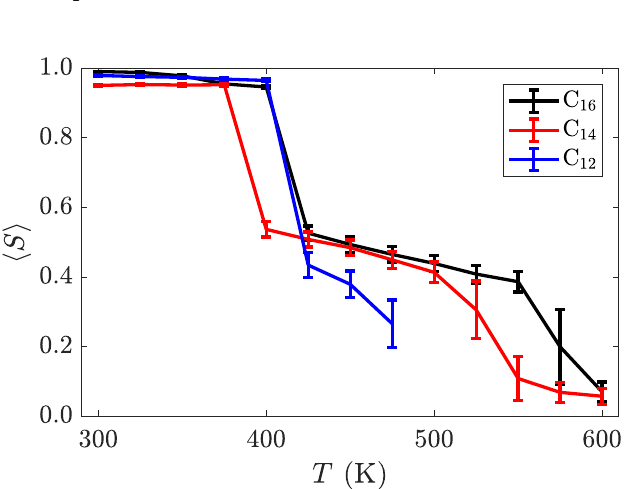
Figure 6. Nematic order parameter as a function of temperature for three different alkyl chain lengths, averaged over the last 200ns of the trajectory. Two distinct phase transitions can be observed a discontinuous jumps in this order parameter. The error bars are larger on temperatures near transition points, as the systems fluctuate more there, thus introducing more variance into trajectory- averaged properties.